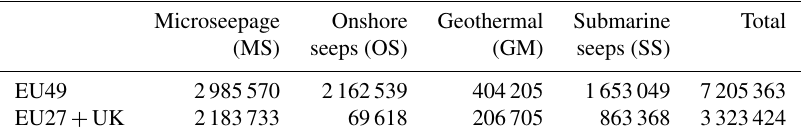
Table A5. European geo-CH 4 emission estimates (Tgyr − 1 ). Etiope (2009) Petrescu et al. (2021) This work Geographic Europe (onshore + off- shore, including